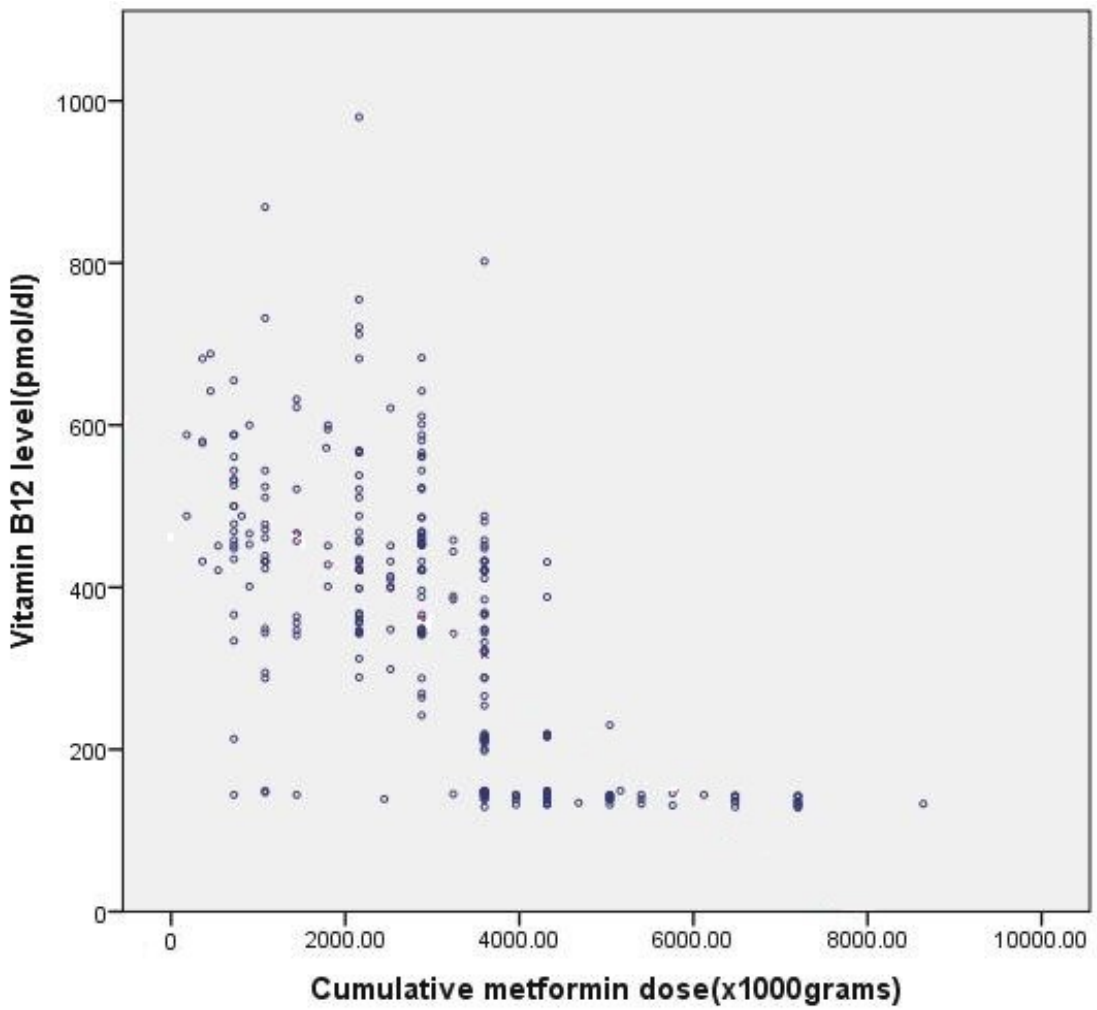
Figure 1. (Scatter diagram): Relationship between cumulative dose of metformin and B12 deficiency. (Pearson Correlation coefficient is − 0.6 and p valve < 0.001). Table 3. Post-hoc (Tukey’s Honest Significant Difference) for intergroup comparison of patients on metformin. B12 Deficiency Sig.